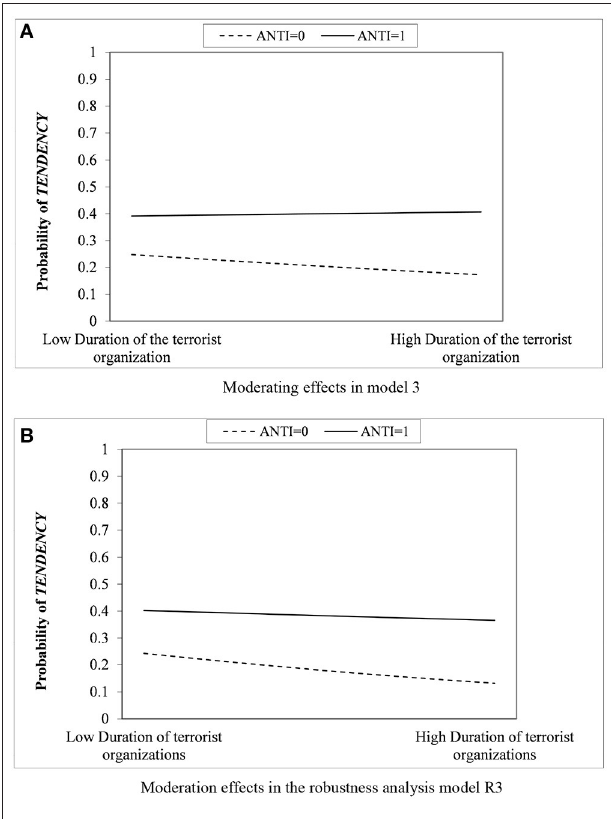
FIGURE 4 | Coercive isomorphic moderating effects in terrorist duration-explosive tendency. (A) Moderating effects in model 3. (B) Moderation effects in the robustness analysis model